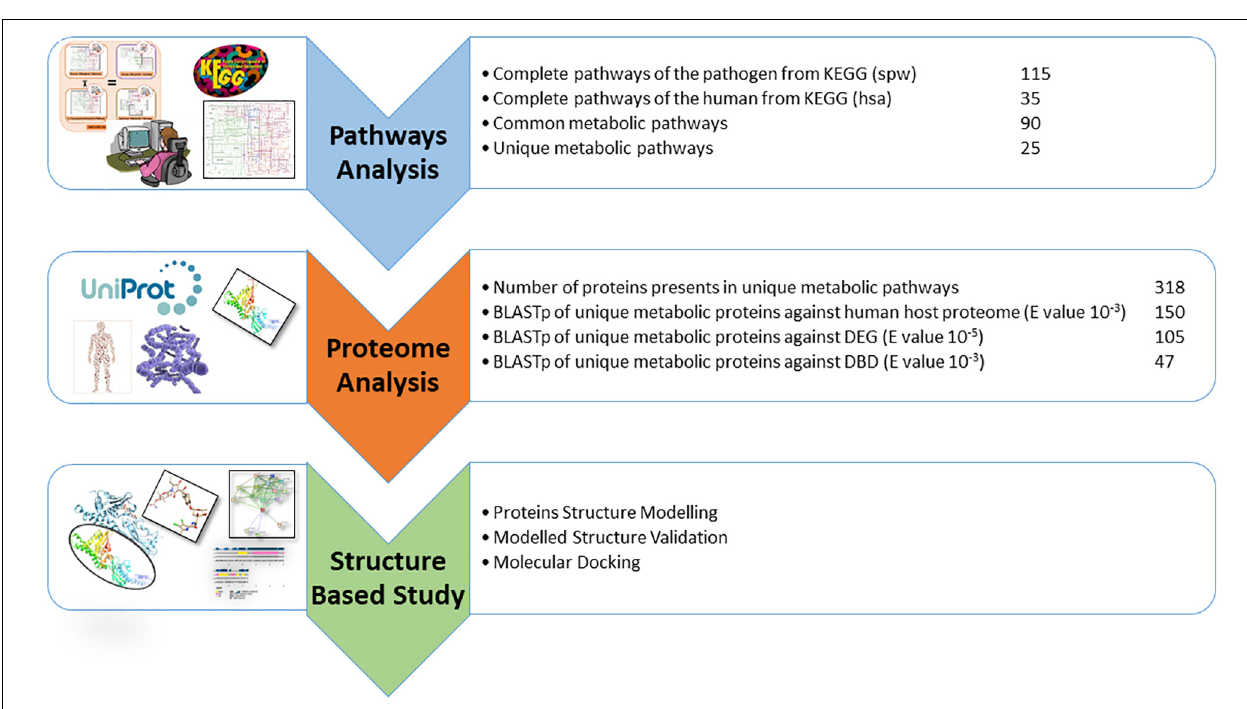
with P0A4I6 (strain ATCC BAA-255/R6), P0A4I5 (serotype 4 strain ATCC BAA-334/TIGR4), A0A0H2ZQ10 (serotype 2 strain D39/NCTC 7466), J1DIP7 (strain 2070335), A5M9S1